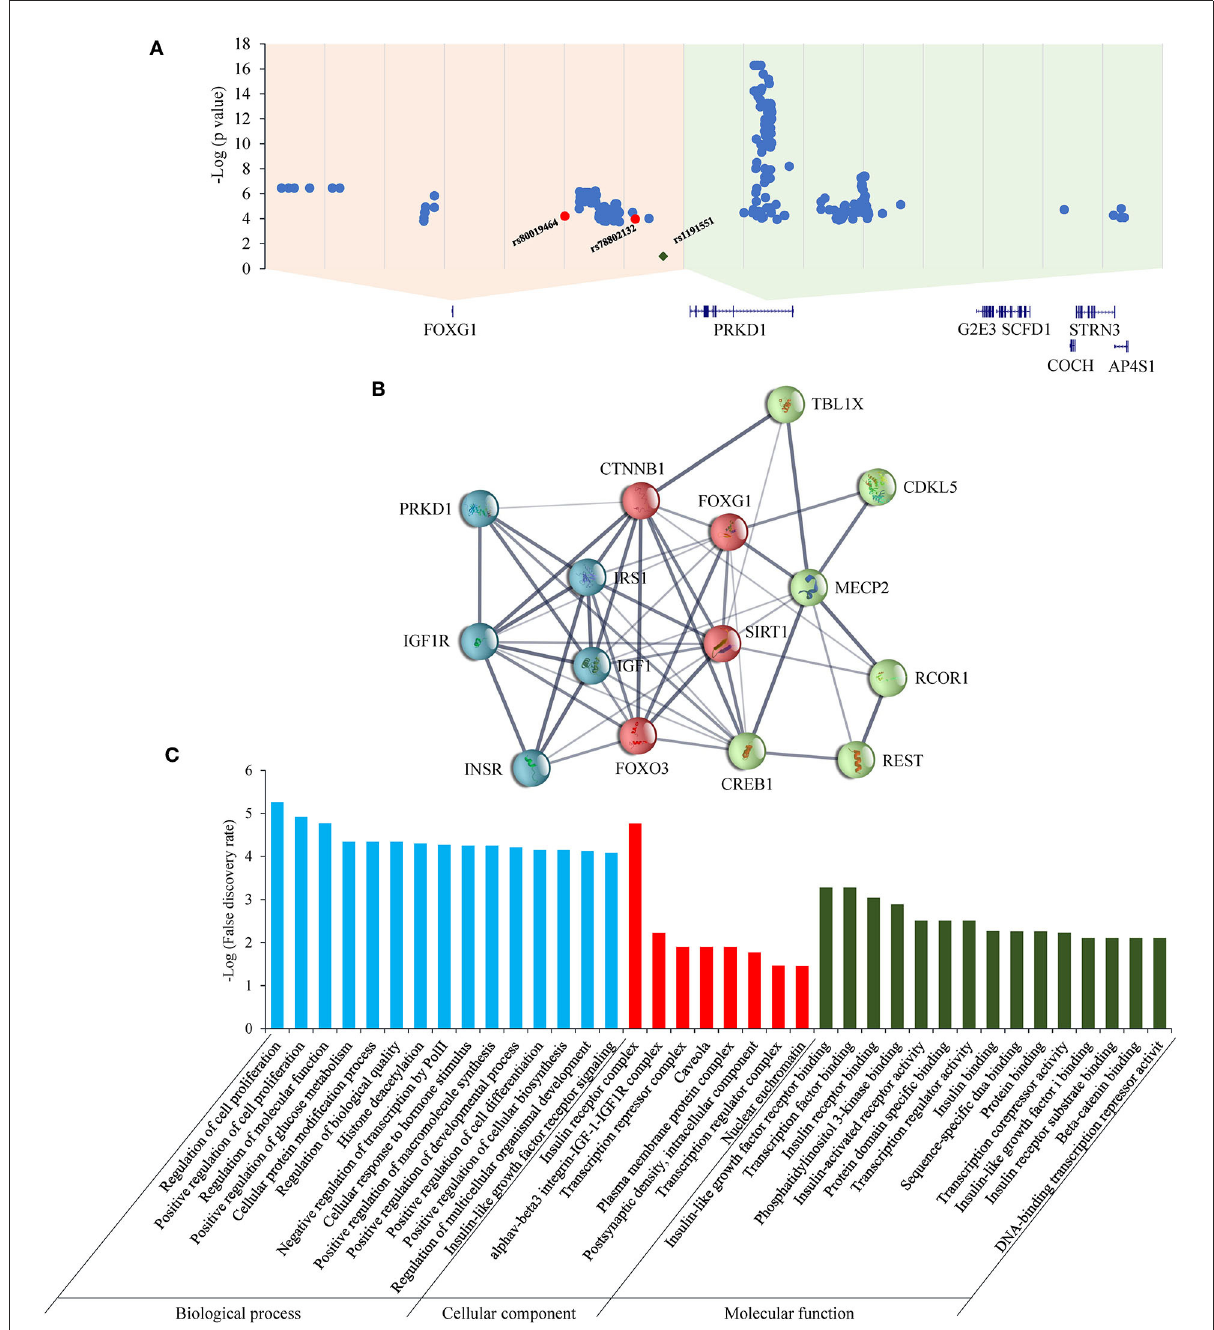
FIGURE7 eQTLs and STRINGed network analysis for FOXG1 and PRKD1. (A) eQTLs for FOXG1 and PRKD1; (B) STRINGed protein interaction network. (C) GO analysis for the interacting components.